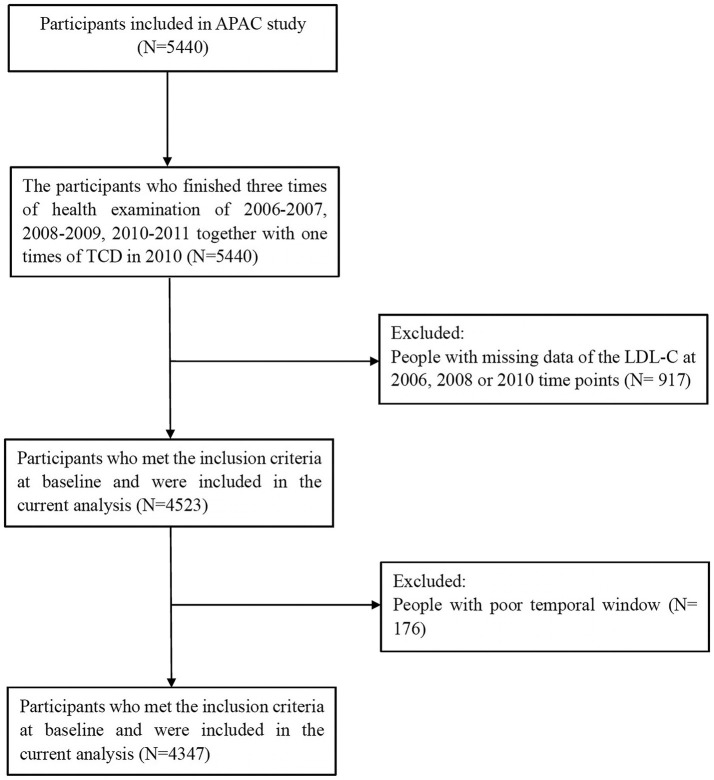
Study flow chart.